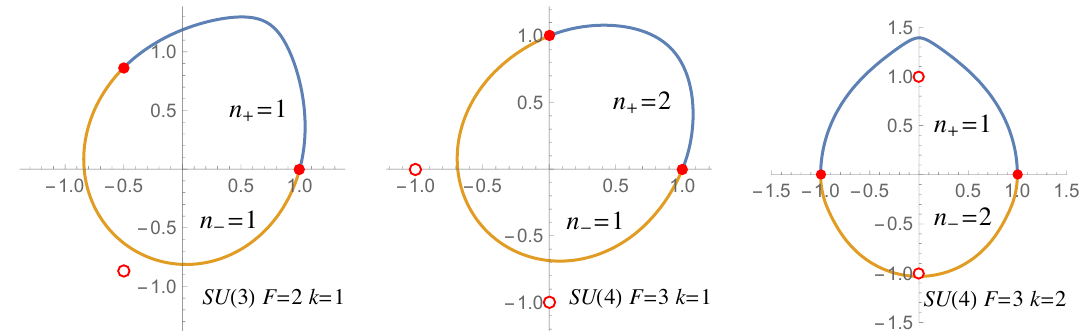
Figure 5: Symmetry breaking k -walls in massive SU ( N ) SQCD with N = 3,4 and F = N − 1 flavors. Each figure refers to a specific domain wall for given values of N , F , k , J . We draw the (smooth) orbits in the complex plane of a solution to the differential equations (5.19), in which n + eigenvalues are equal to λ + and n − are equal to λ − ( n + + n − = F